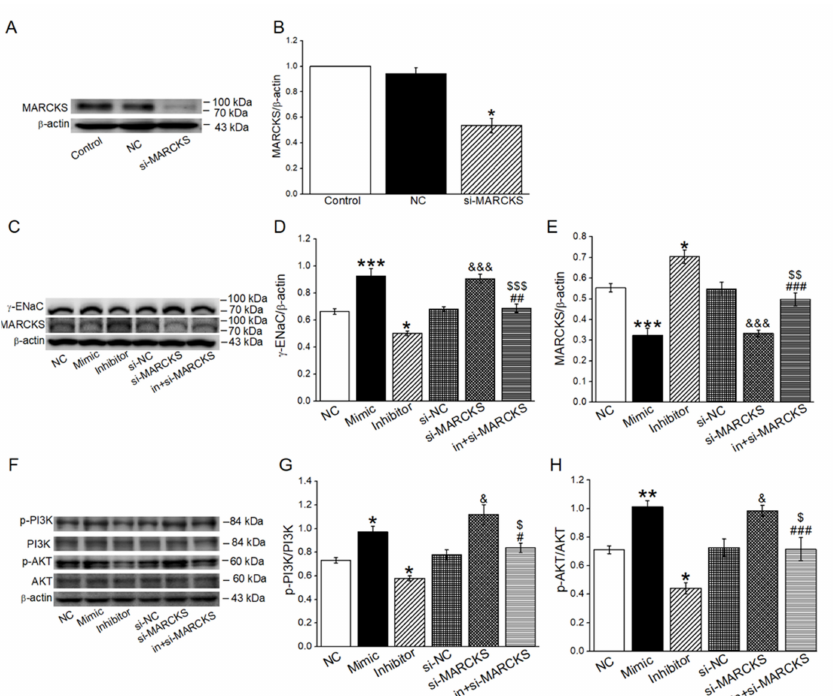
Figure 6. MiR-34c and MARCKS regulated γ -ENaC through PI3K/AKT pathway. ( A ) Representa- tive Western blot bands of MARCKS protein expression in H441 cells transfected with si-MARCKS. ( B ) Graphical representation of data obtained from Western blot assays for MARCKS and quan- tified through gray analysis (MARCKS/ β -actin) ( n = 4). ( C ) Representative Western blot bands of γ -ENaC and MARCKS in H441 cells transfected with miR-34c mimic, miR-34c inhibitor and si-MARCKS, respectively. ( D , E ) Graphical representation of data obtained from Western blot assays for γ -ENaC protein and MARCKS protein. Bands were quantified by using gray analysis ( γ -ENaC/ β - actin and MARCKS/ β -actin) ( n = 5). ( F ) Representative Western blot bands of p-PI3K/PI3K and p-AKT/AKT in H441 cells transfected with miR-34c mimic, miR-34c inhibitor and si-MARCKS, re- spectively. ( G , H ) Graphical representation of data obtained from Western blot assays for p-PI3K/PI3K and p-AKT/AKT. Bands were quantified by using gray analysis (p-PI3K/PI3K and